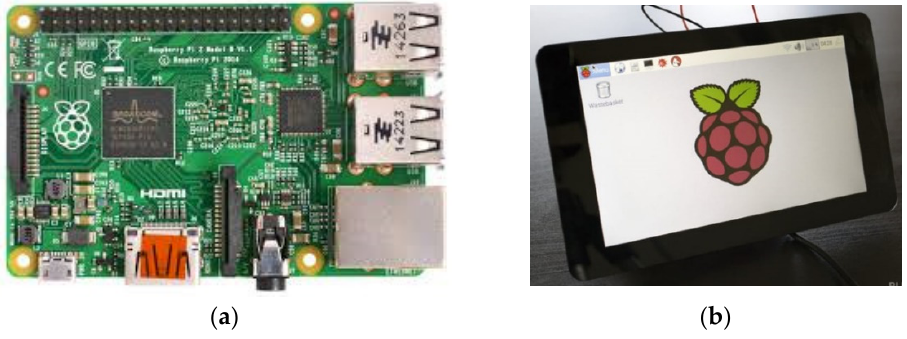
Figure 11. Control system: ( a ) Raspberry Pi 2B; ( b ) touchscreen.